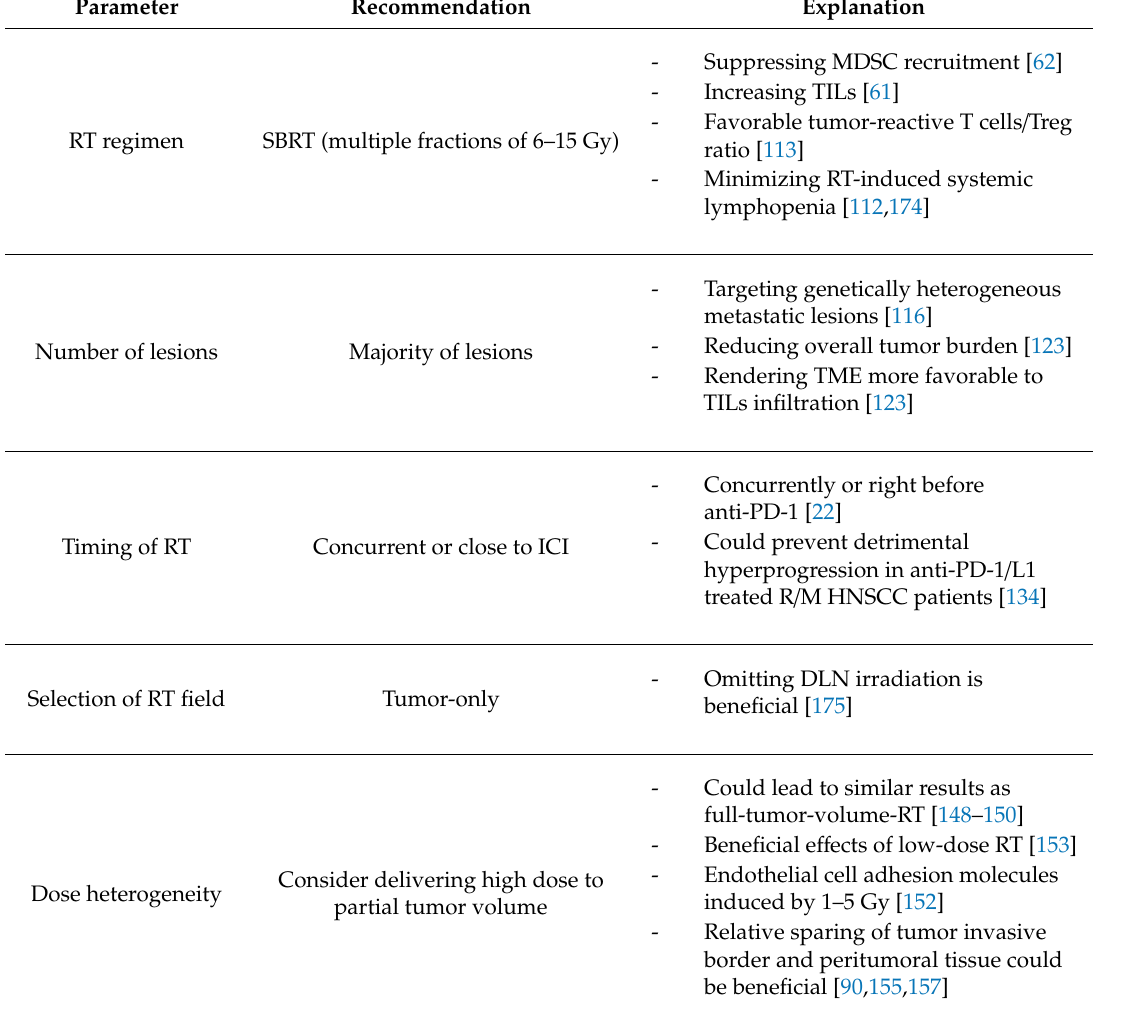
Table 2. Radiotherapy-related parameters to be considered in future clinical trials on combination of radiotherapy and immune checkpoint inhibitors in patients with recurrent or metastatic squamous cell carcinoma of the head and